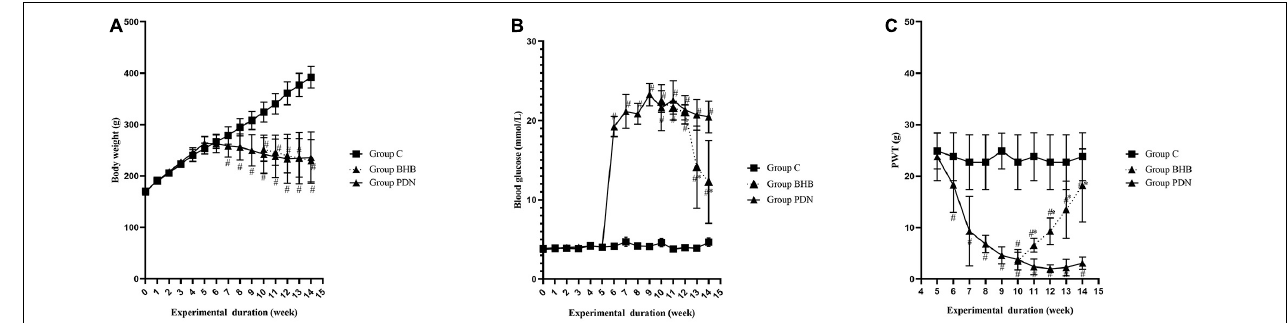
FIGURE 2 | Trend of bodyweight, blood glucose, PWT in each group. (A) The trend of bodyweight in Group C, Group PDN, and Group BHB. (B) The trend of blood glucose in Group C, Group PDN, and Group BHB. (C) The trend of PWT in Group C, Group PDN, and Group BHB. At the fifth week of feeding, rats in Group PDN were intraperitoneally injected with STZ, and rats in Group C were intraperitoneally injected with sterile saline. Rats in Group BHB were intraperitoneally injected with STZ at the fifth week of feeding and BHB at the 10th week of feeding. The one-way analysis of variance (ANOVA) was used to compare means between groups. The repeated-measures ANOVA was used to compare the PWT. Post hoc analyses were conducted using the Bonferroni correction method. Values were presented as mean ± SEM. * p < 0.05 compared with values in Group PDN. # p < 0.05 compared with values in Group C.